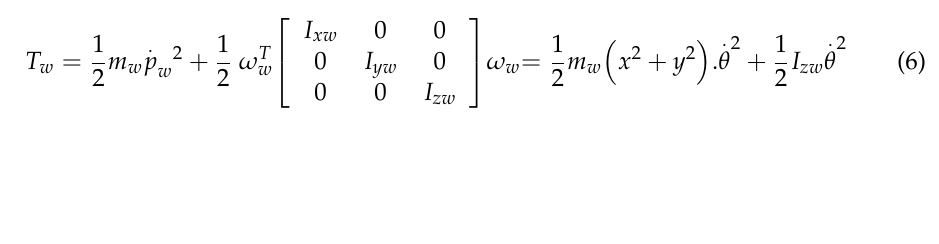
Figure 4. Modeling of system parameters for a human hand. The kinetic energy of the hand